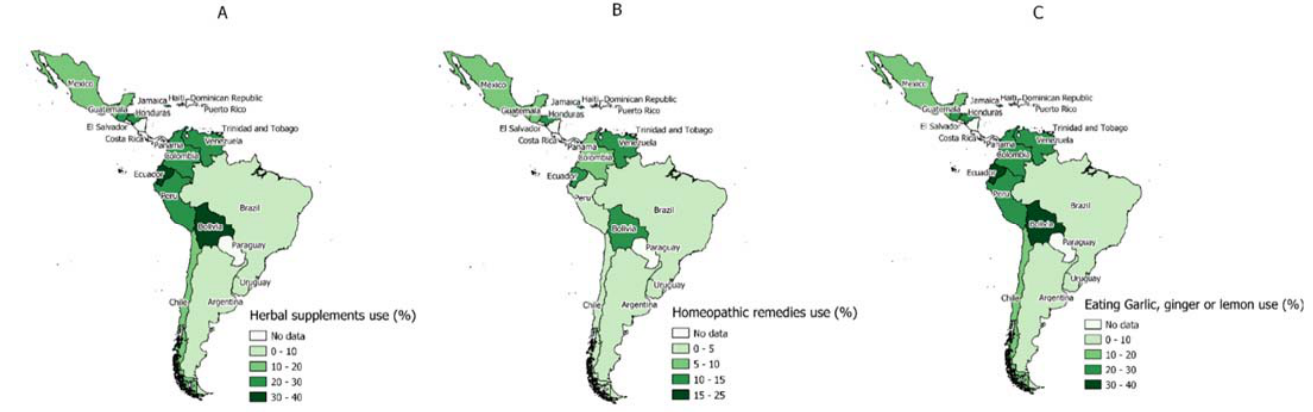
Figure 2. ( A ) Prevalence of use of herbal supplements in adults surveyed from 14 Latin American countries. ( B ) Prevalence of use of homeopathic remedies in adults surveyed from 14 Latin American countries. ( C ) Prevalence of consumption of garlic, ginger, or lemon in adults surveyed from 14 Latin American countries.